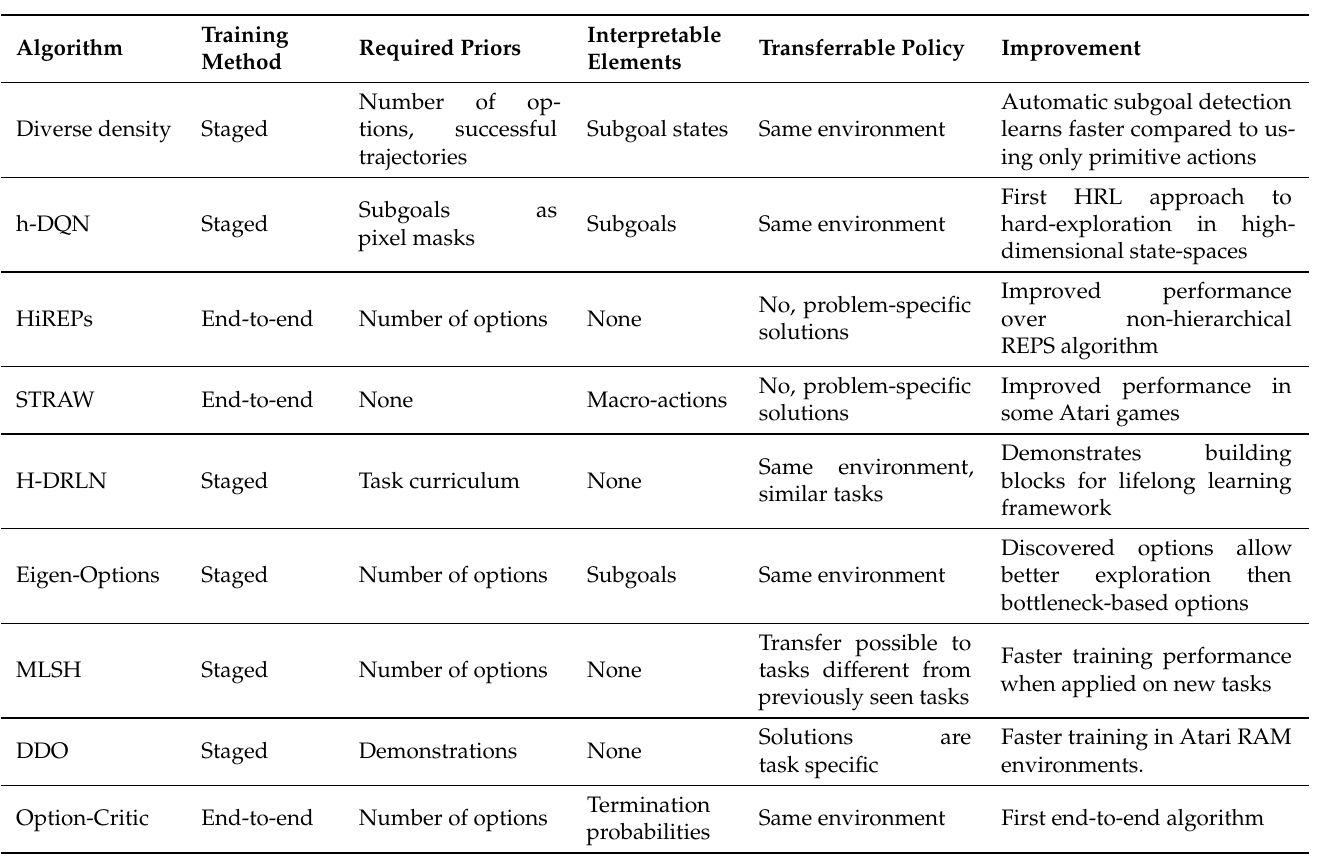
Table 3. Evaluation of option